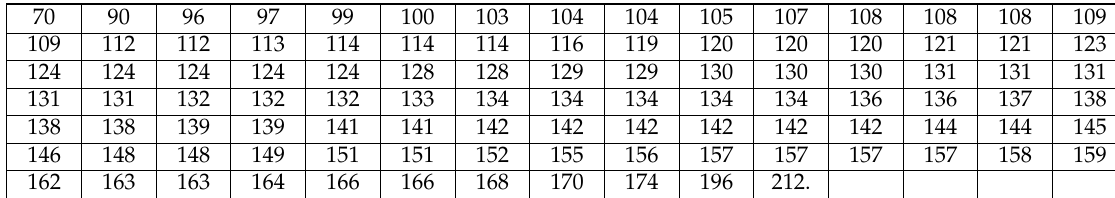
Table 1. Fatigue data of aluminum in hours.